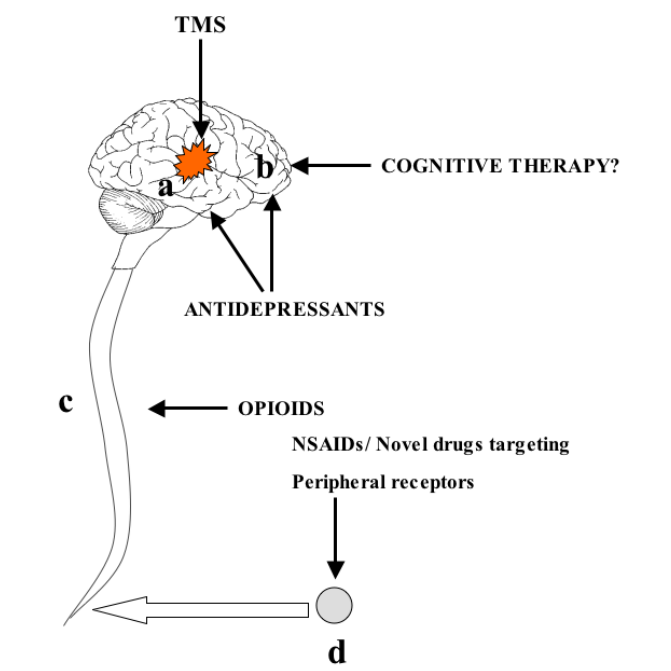
FIGURE 3 . Examples of treatments used for chronic pain and its potential targets in the nervous system areas (a, secondary somatosensory area; b, limbic areas including the cingulate cortex; c, spinal cord; d, peripheral